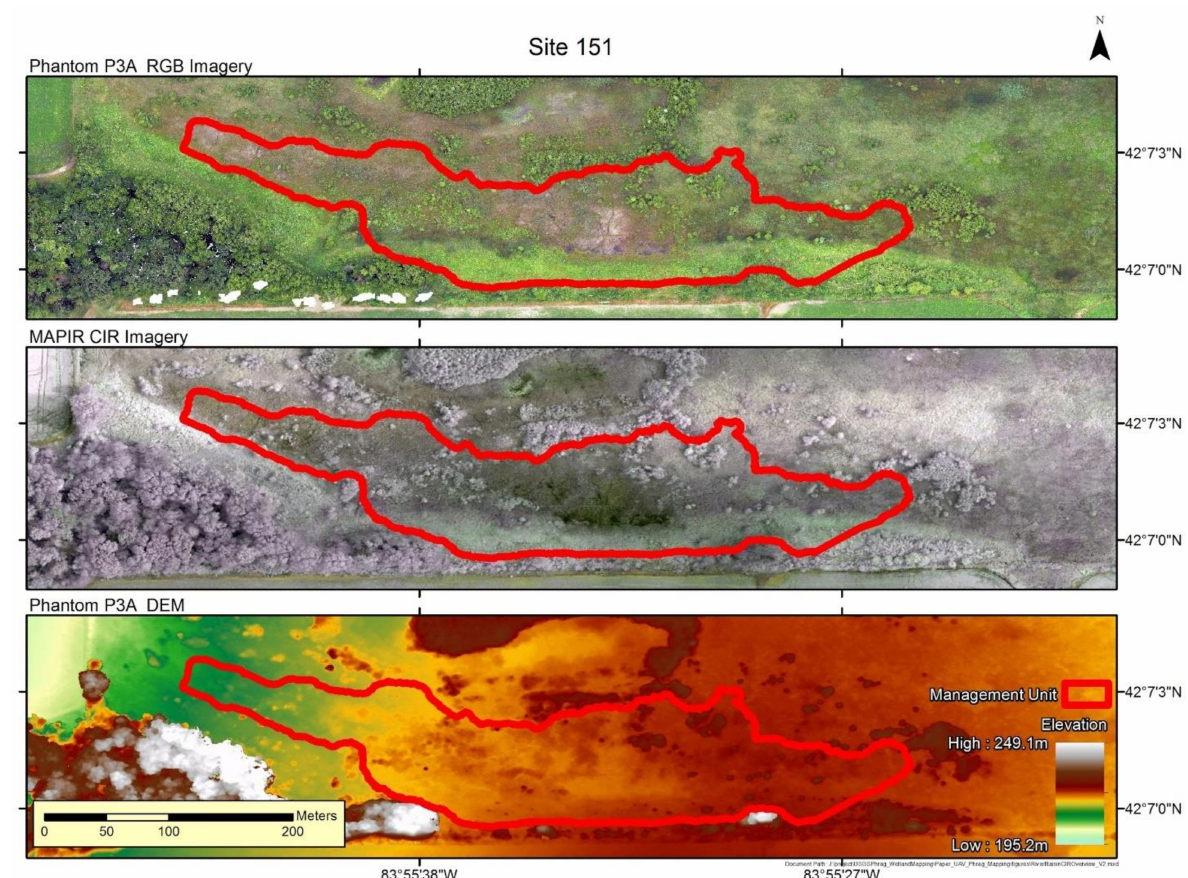
Figure 6. Comparison of Phantom 3 RGB orthophoto imagery to MAPIR NIR orthophoto imagery and a DSM derived from the Phantom 3 imagery, created with